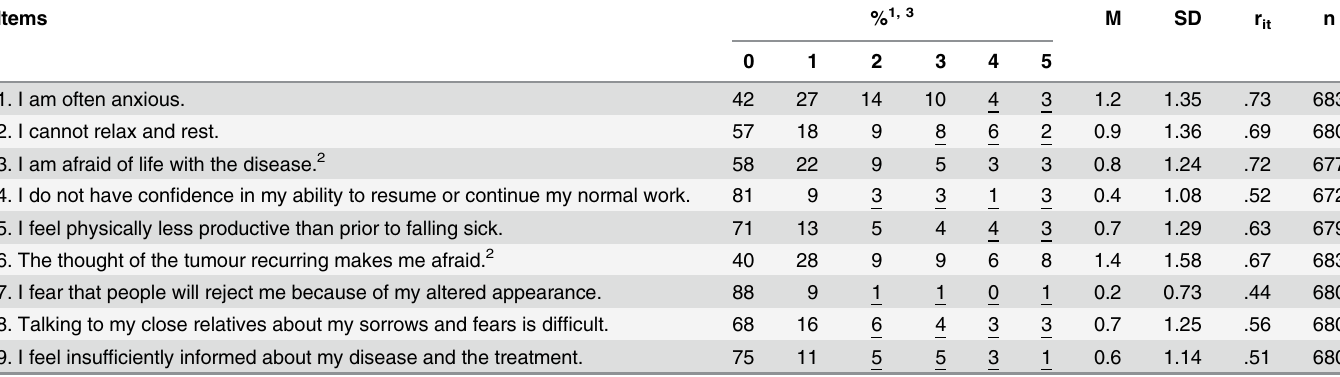
Table 2. Item and scale analysis of the Hornheide Questionnaire short form (HQ-S).